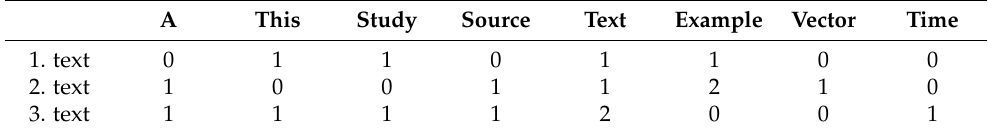
Table 1. The working of Count Vectorizer.